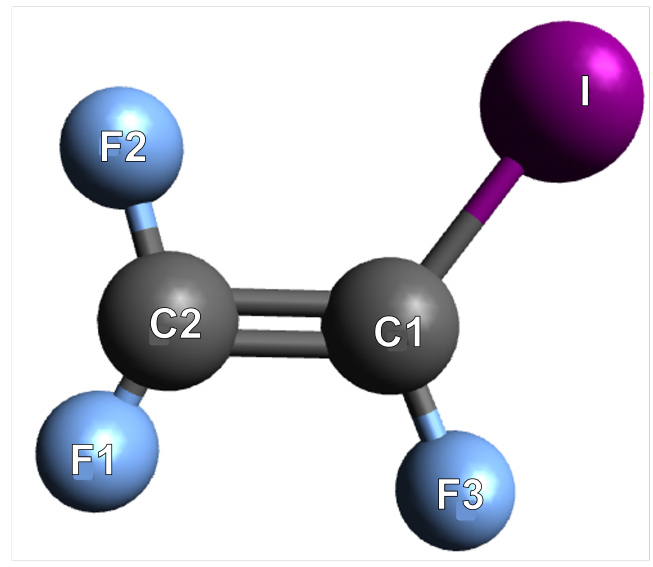
Figure 2. Iodotrifluoroethylene (TFE)